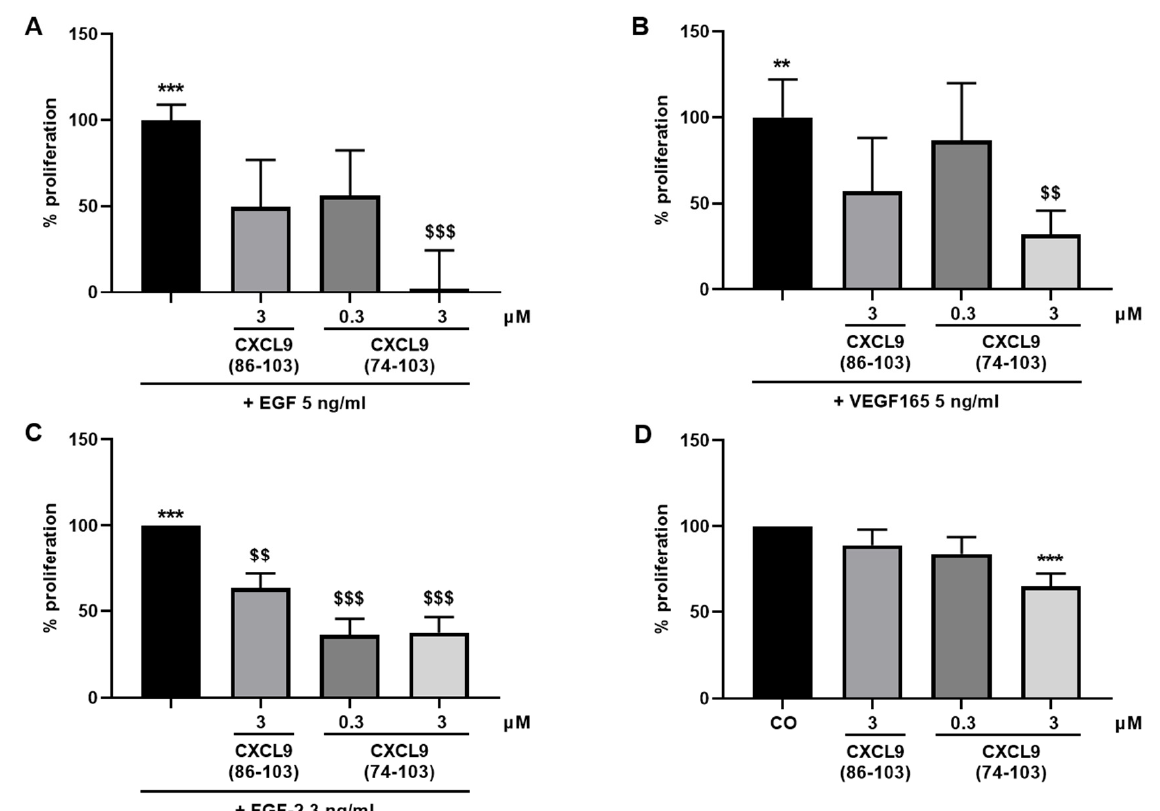
Figure 1. CXCL9(74-103) reduces growth factor-induced and basal endothelial cell proliferation. HMVECs were stimulated with ( A ) EGF, ( B ) VEGF165, or ( C ) FGF-2 as single stimulus or in combination with CXCL9(86-103) or CXCL9(74-103), or ( D ) CXCL9(86-103) and CXCL9(74-103) as a single stimulus at the indicated concentrations. After 3 to 4 days, the effect of the CXCL9-derived peptides on growth factor-induced and basal proliferation was determined. The mean ( ± SEM) proliferation compared to growth factor-induced ( A – C ) or compared to the control ( D ) (100%) is shown [n ≥ 4; Mann–Whitney U